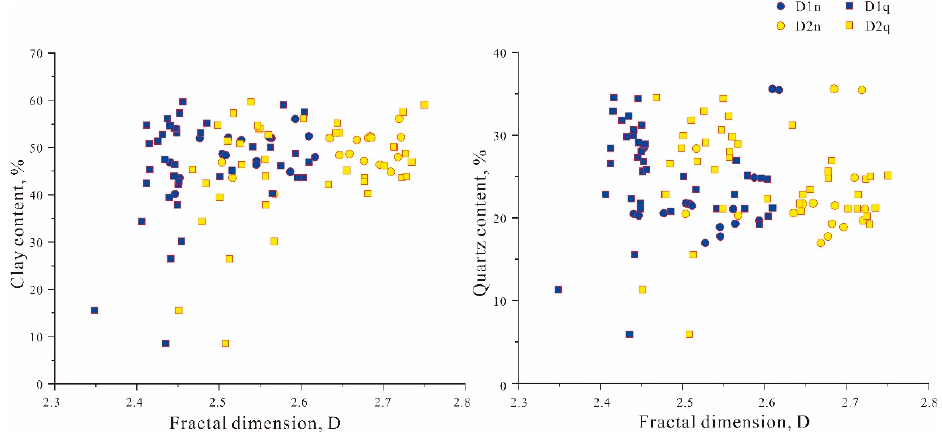
Figure 9. Relationships between mineral compositions and fractal dimensions of K 2 n 1+2 and K 2 q shale. The K 2 q compared to [78].